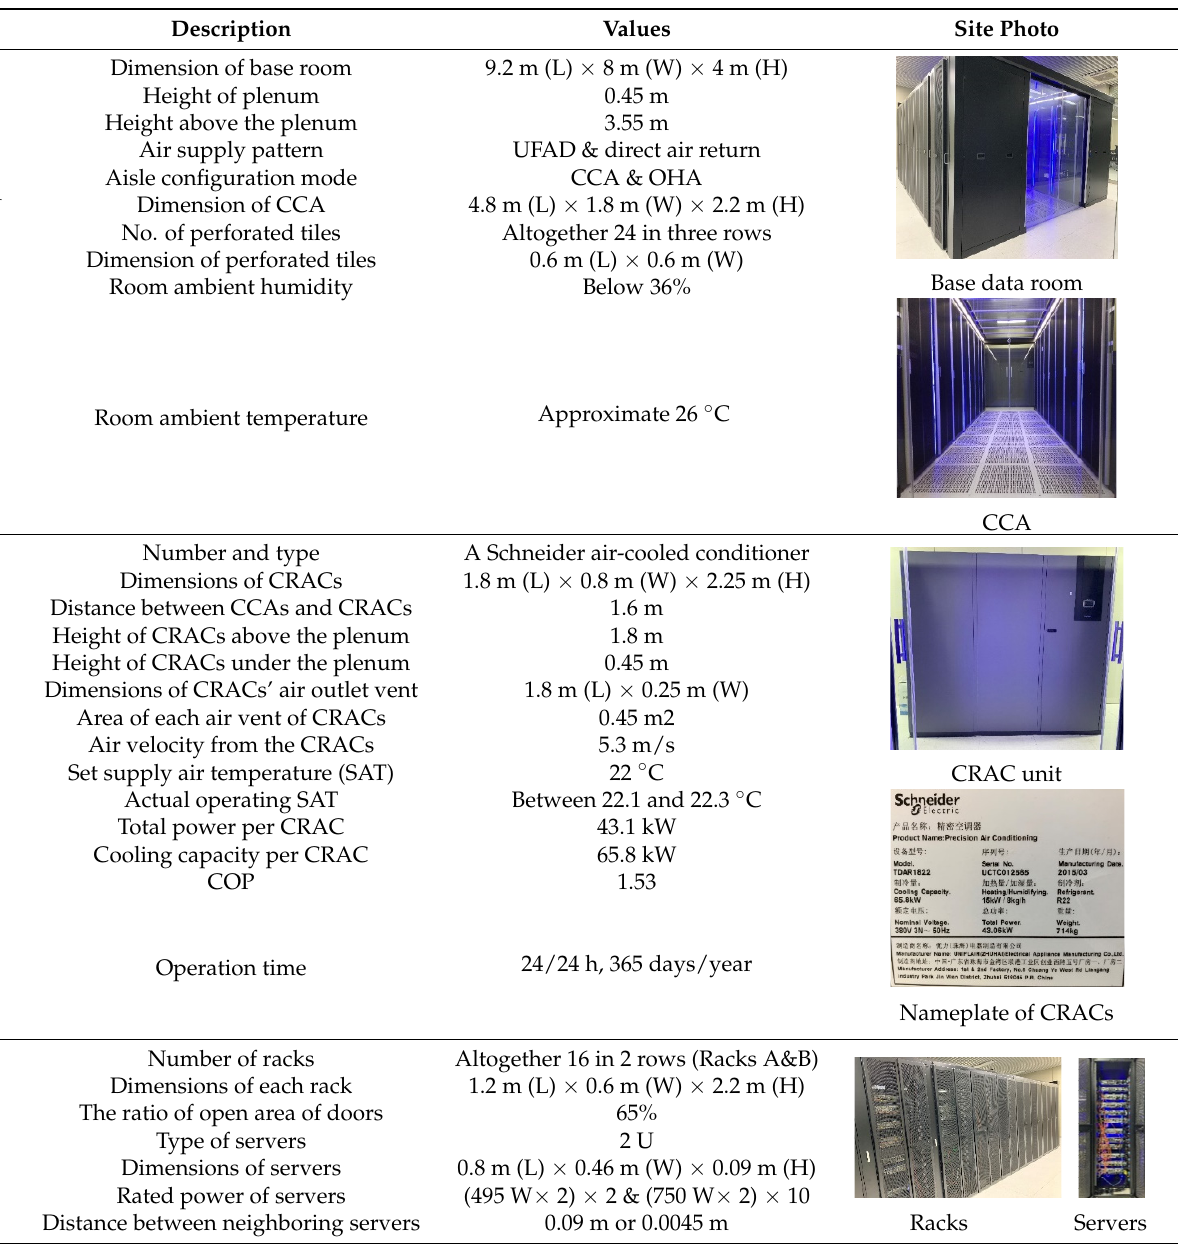
Table 1. Parameters of the base room and its equipment.